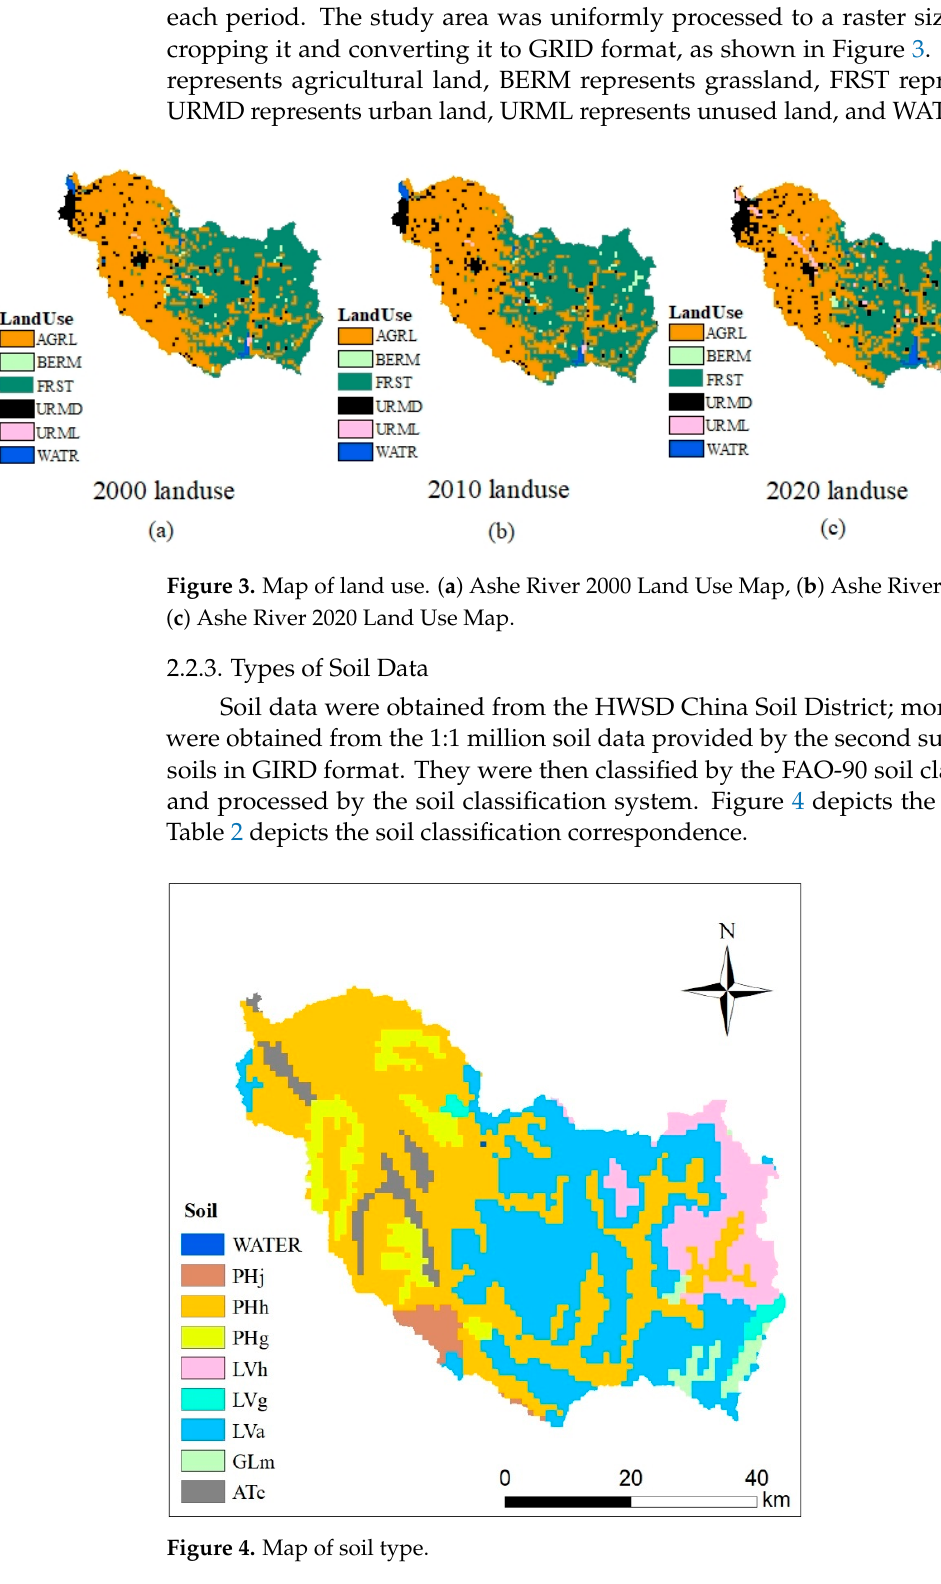
Figure 2. Map of watershed.